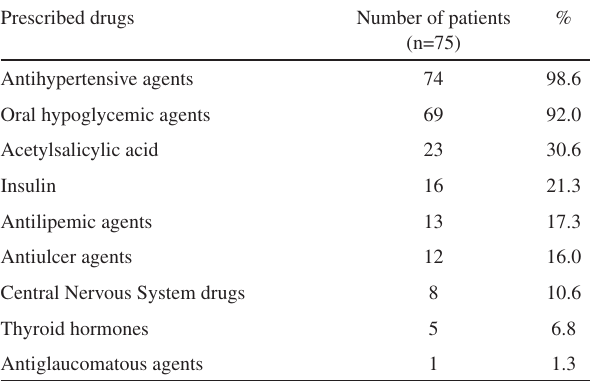
Table 7 - Number and percentage of patients by prescribed drug category